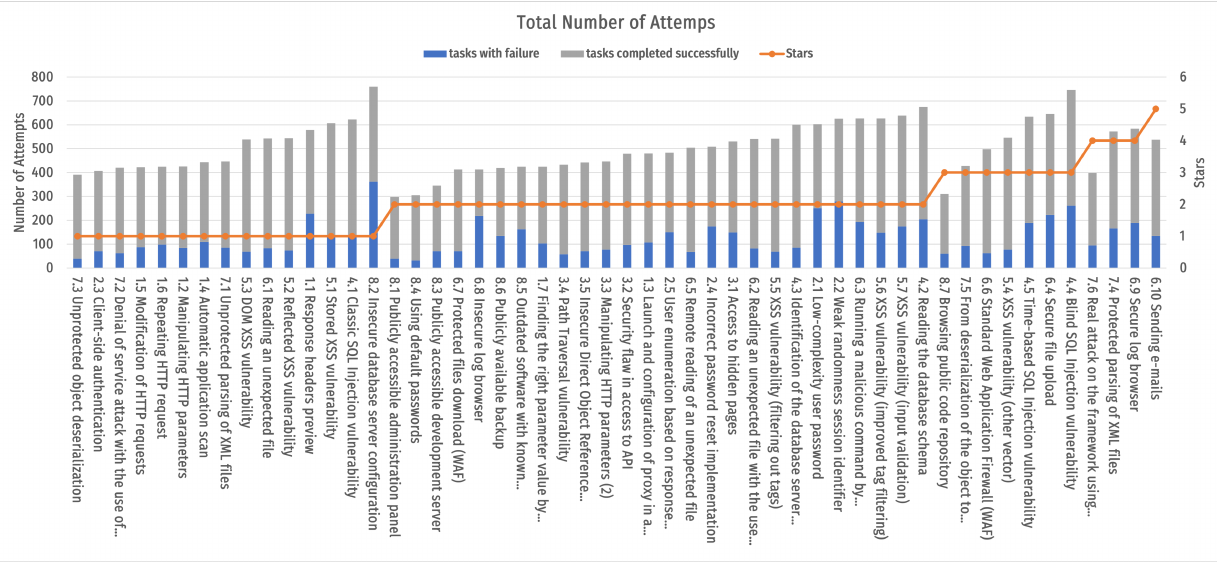
Figure 13. Total number of attempts taken on each task with the set difficulty